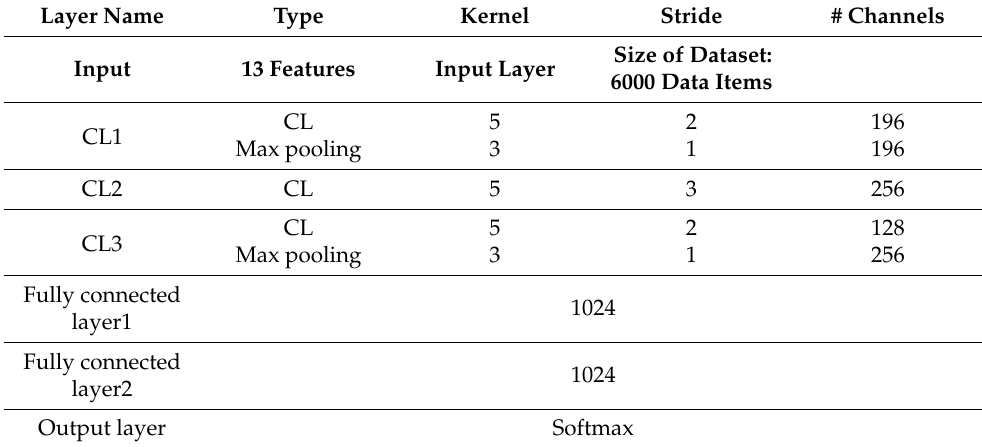
Table 4. The proposed CNN for the small-sized